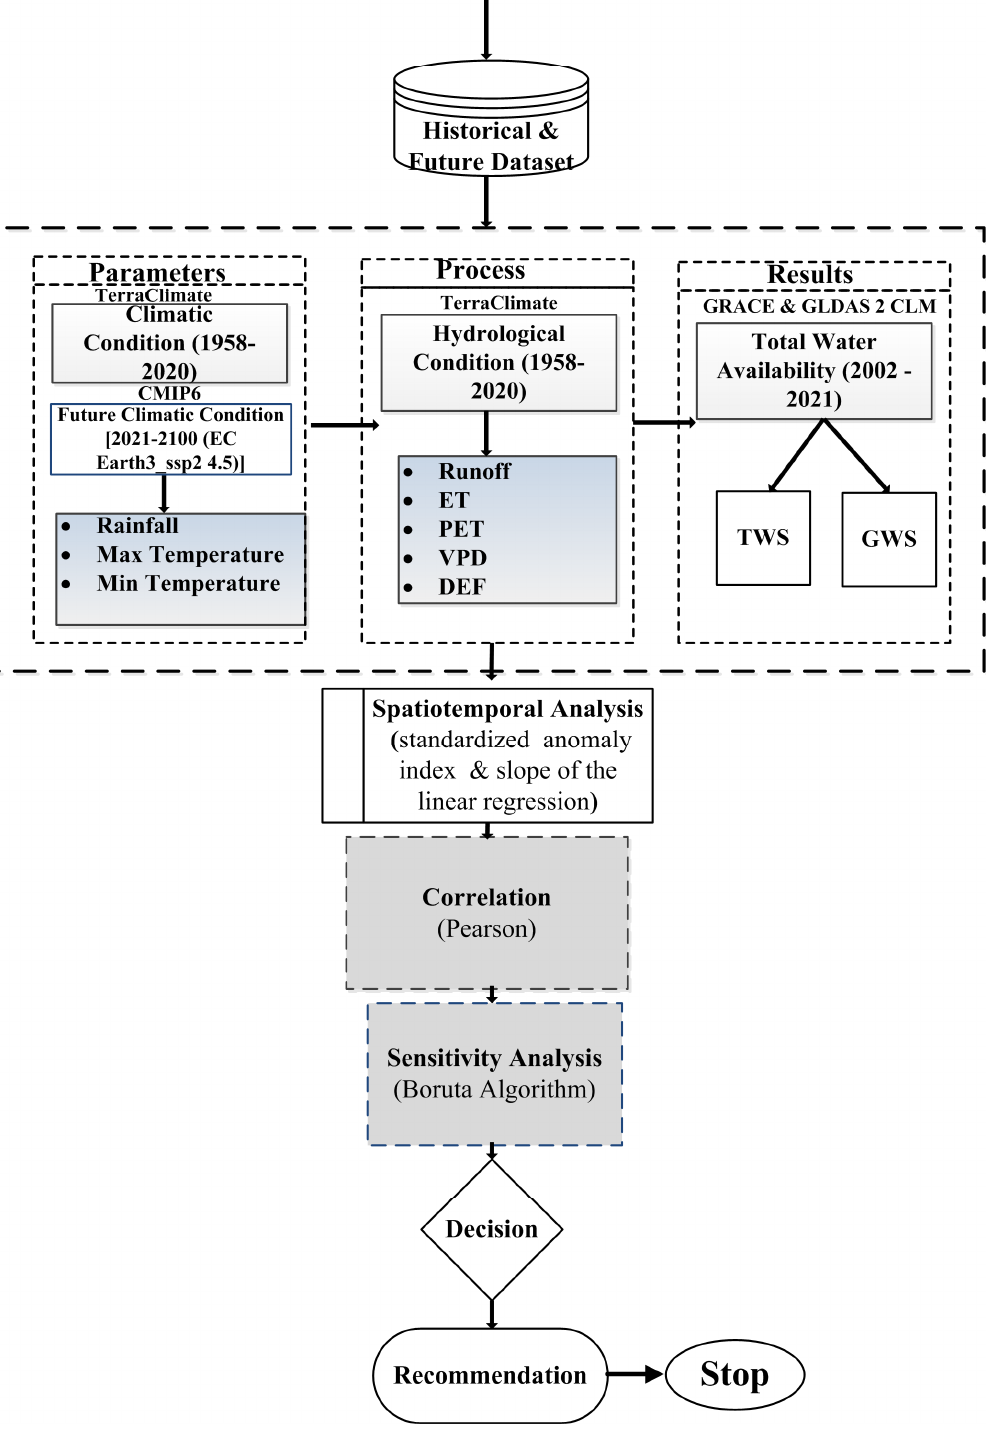
Figure 2. Overall methodological framework.